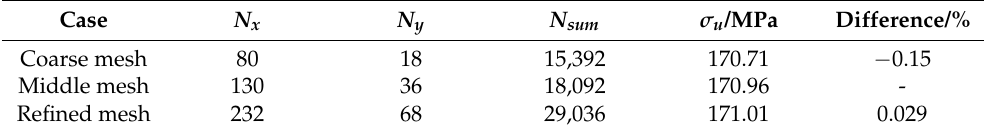
Table 3. Results of convergence